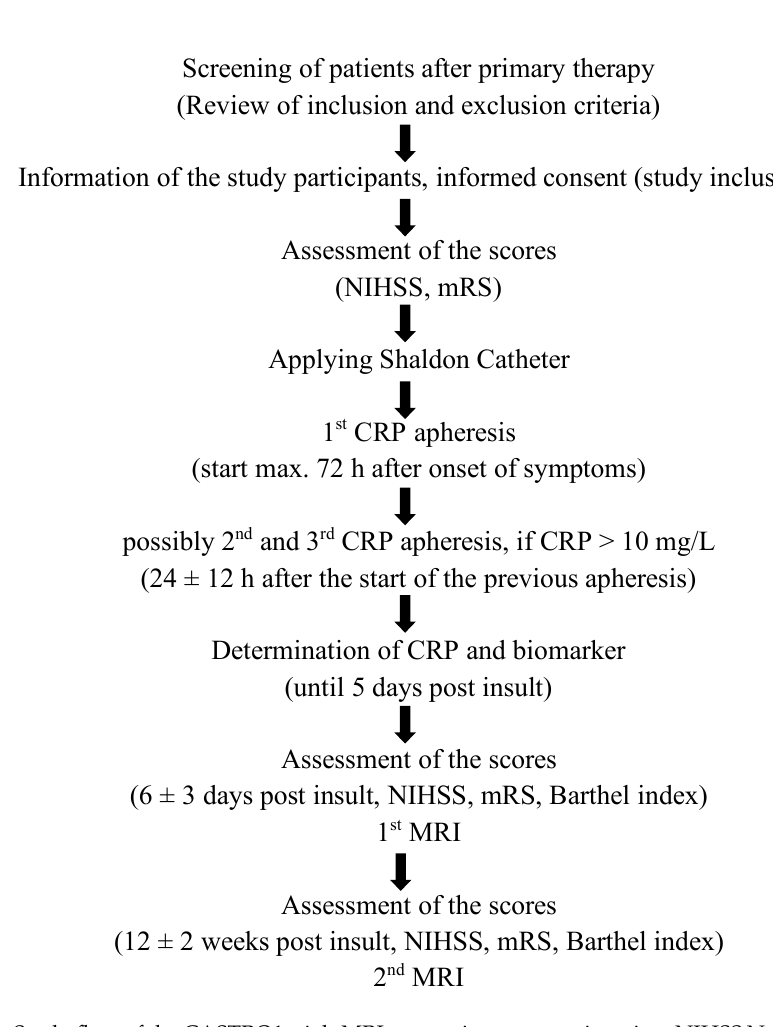
Figure 4. Study flow of the CASTRO1 trial. MRI magnetic resonance imaging; NIHSS National Institute of Health Stroke Scale; mRs modified Rankin